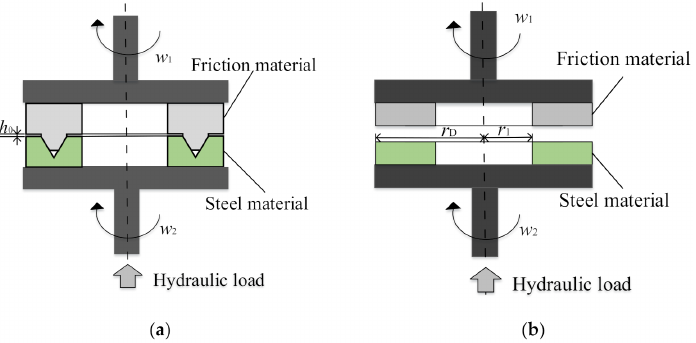
Figure 1. Friction model for conical groove friction element ( a ) single cone ring friction element, ( b ) simplified contact model [25].